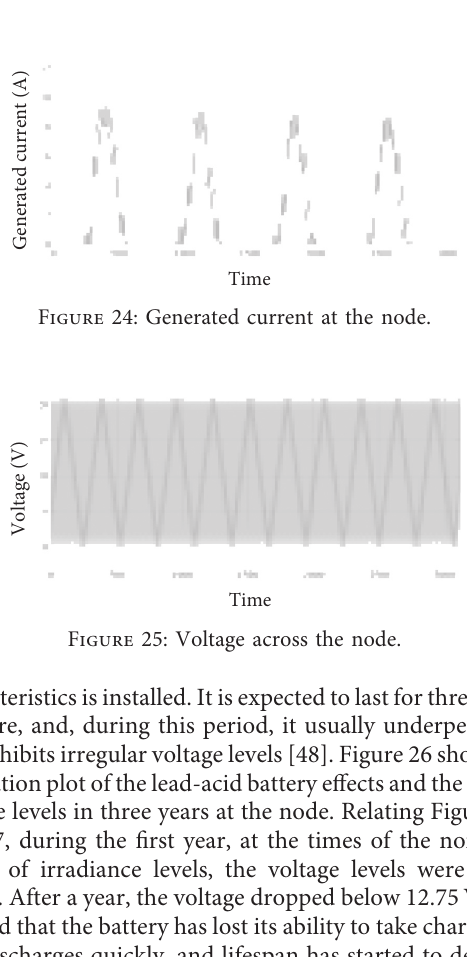
Figure 27: The lead-acid battery voltage for 3-year